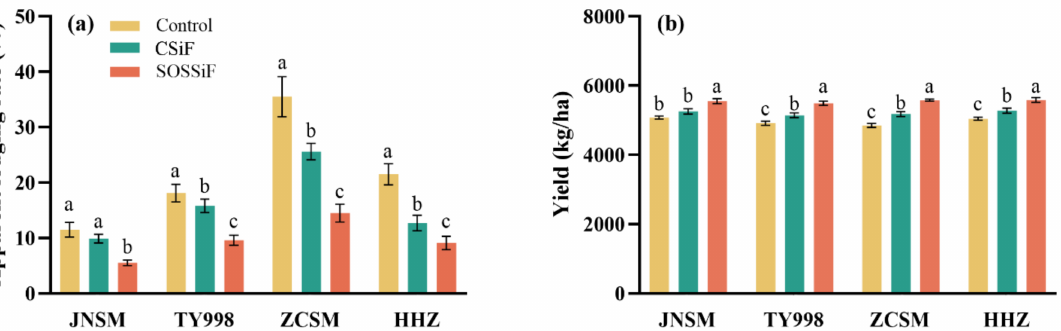
Figure 2. Apparent lodging rate ( a ) and yield ( b ) of rice treated with different Si treatments under high N level. Different small letters above the histogram of the same rice variety indicated significant differences ( p ≤